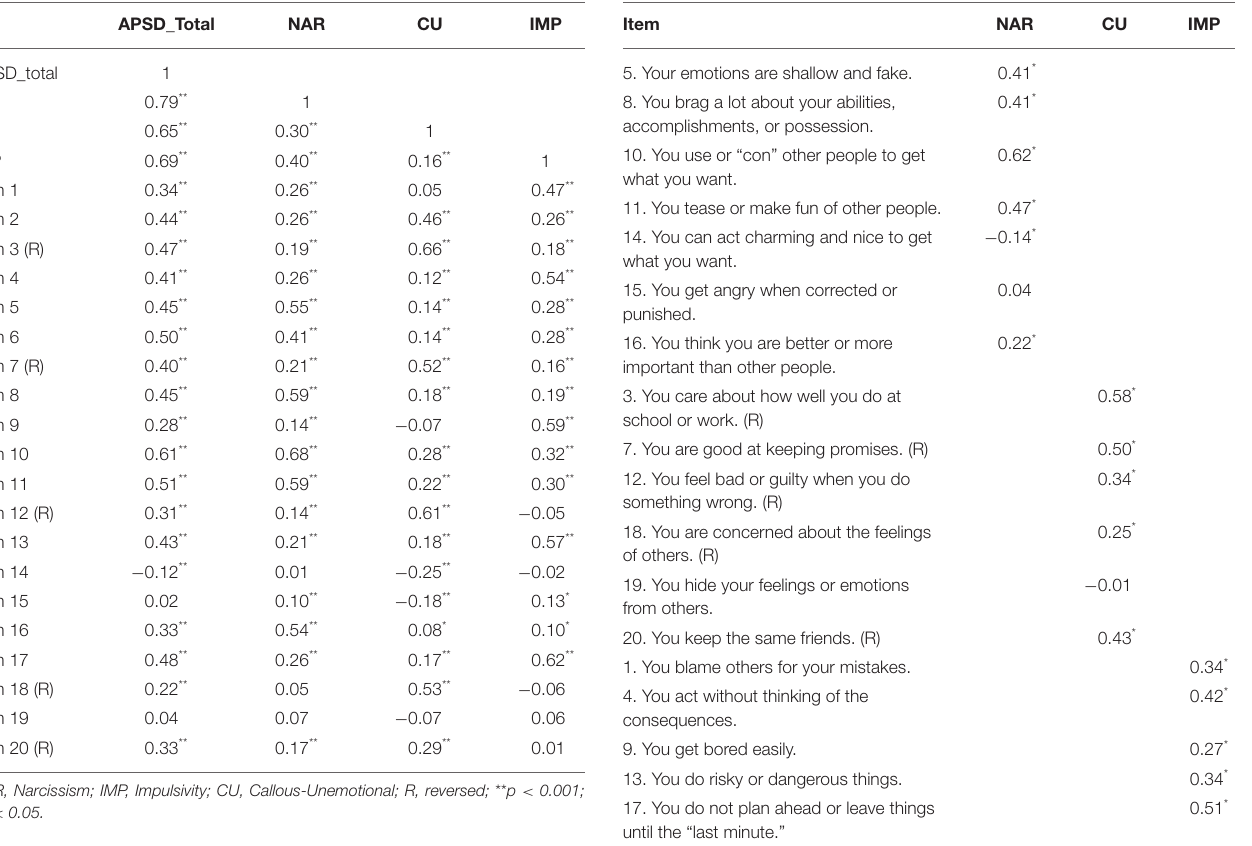
TABLE 2 | Item-total and item-factor correlations of APSD-SR ( n = 675). TABLE 3 | APSD-SR item